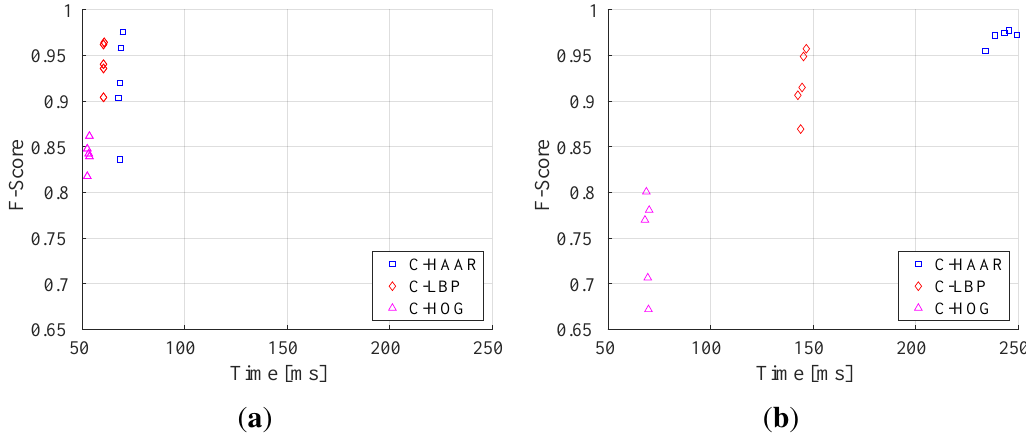
Figure 21. ( a ) Indoor and ( b ) outdoor scatter plots for F-score and mean running times. Each F-score value corresponds to a different classifier with different numbers of stages at the threshold resulting in the maximum